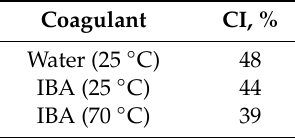
Table 1. The crystallinity index of the fibers formed into water and IBA at 25 ◦ C and 70 ◦ C, then washed in water and dried.